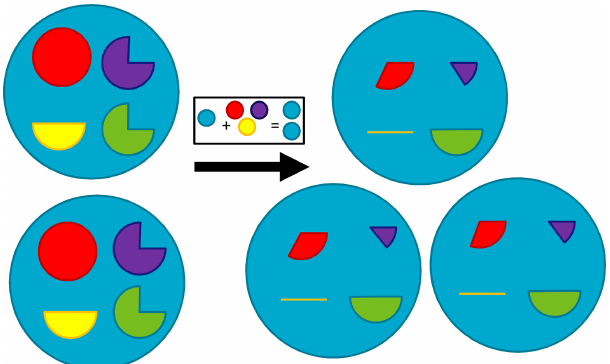
Figure 11. Schematic of the process of microalgae growth from internal reserves. Blue circle: structural material; red pie: nitrogen reserves; purple pie: phosphorus reserves; yellow pie: carbon re- serves; green pie: pigment content. Here, a circular pie has a value of 1, representing the normalised reserve (a value between 0 and 1). The box shows that generating structural material for an additional cell requires the equivalent of 100% internal reserves of carbon, ni- trogen and phosphorus of one cell. This figure shows the discrete growth of two cells to three, requiring both the generation of new structural material from reserves and the reserves being diluted as a result of the number of cells in which they are divided increasing from two to three. Thus, the internal reserves for nitrogen after the population increases from two to three is given by two from the ini- tial two cells, minus one for building structural material of the new cell, shared across the three offspring, to give one-third. The same logic applies to carbon and phosphorus reserves, with phosphorus reserves being reduced to one-sixth and carbon reserves being ex- hausted. In contrast, pigment is not required for structural material so the only reduction is through dilution; the three-fourths content of two cells is shared among three cells to equal one-half in the three cells. This schematic shows one limitation of a population-style model whereby reserves are “shared” across the population (as op- posed to individual-based modelling; Beckmann and Hense,